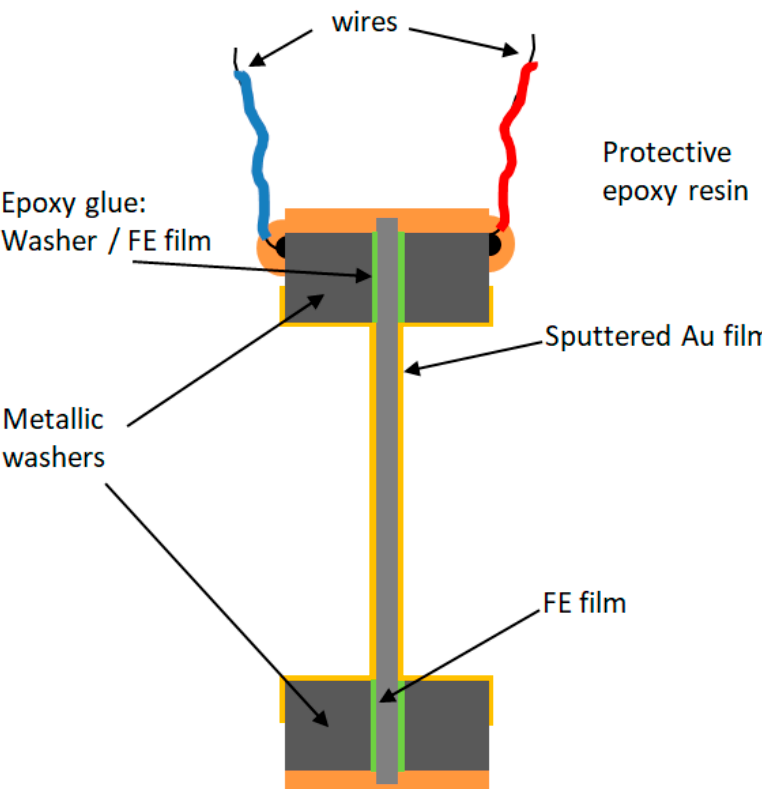
Figure 1. Schematic representation of the FE film preparation.